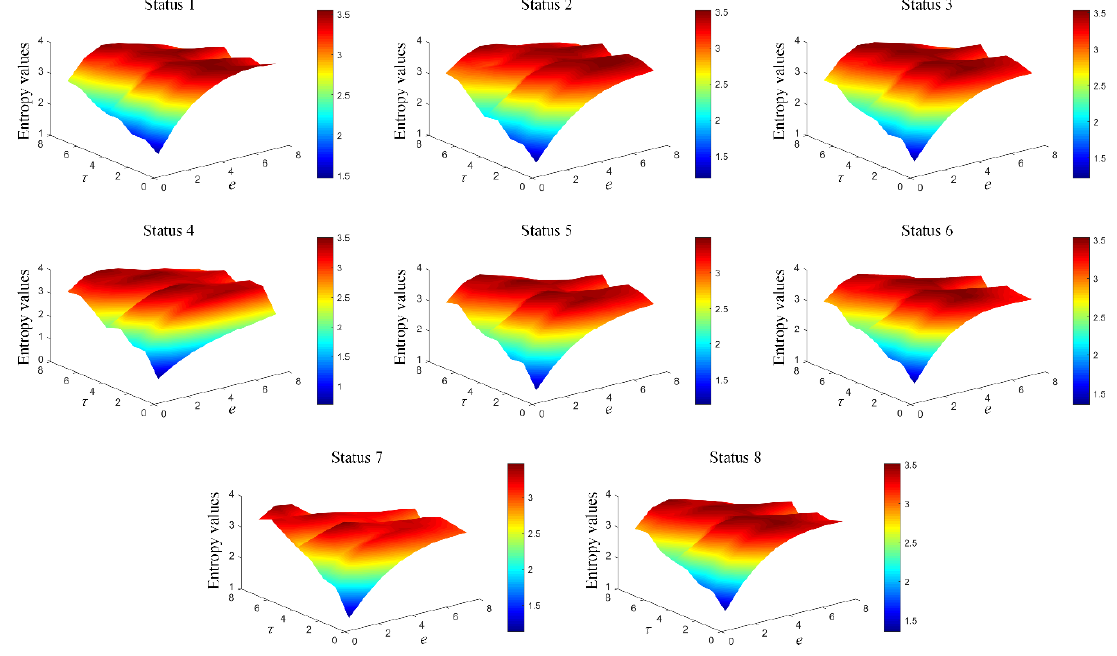
Figure 10. Raw fault features corresponding to different states.